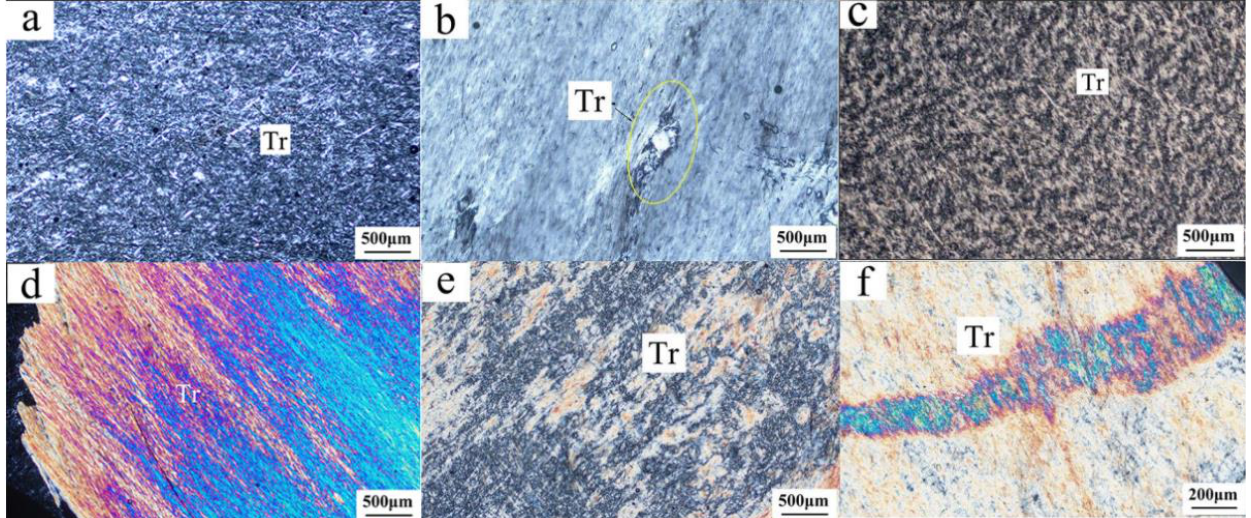
Figure 3. The textural characteristics of the samples. ( a ) Needle – columnar texture. ( b ) Granular tex- ture. ( c ) Felted – fibrous interlaced texture. ( d ) Fibrous blastic texture. ( e ) Foliated blastic texture. ( f ) Vein-like texture. Tr: tremolite.